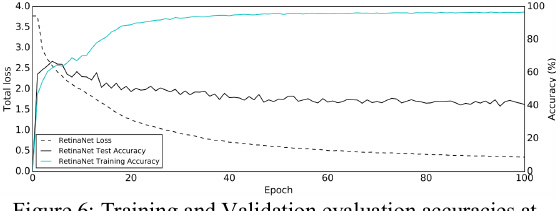
Figure 6: Training and Validation evaluation accuracies at IoU=0.5. The simultaneous increase in training accuracy and decrease in validation accuracy is a classic sign of over- fitting of the training data.